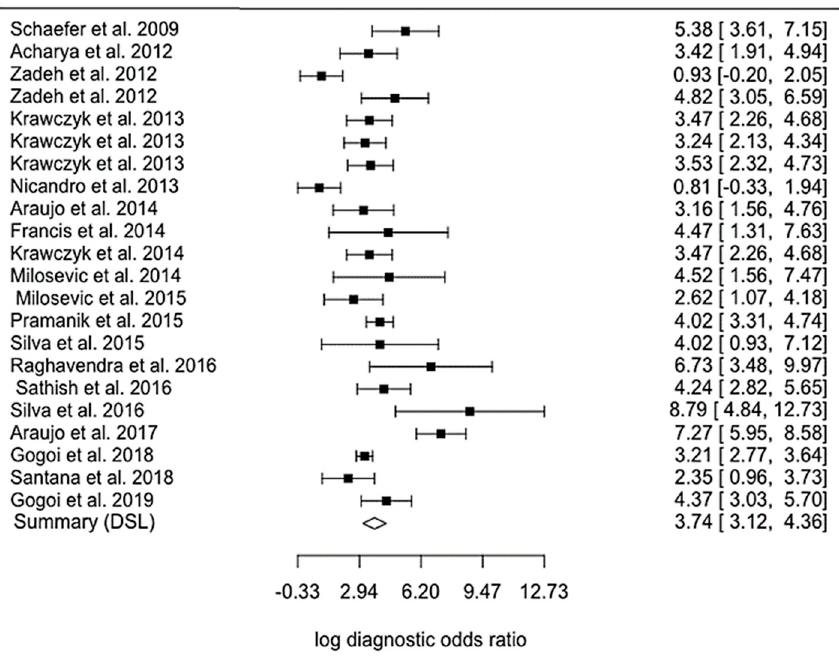
Figure A3. Forest plots for log diagnostic odd ratios for breast cancer studies.